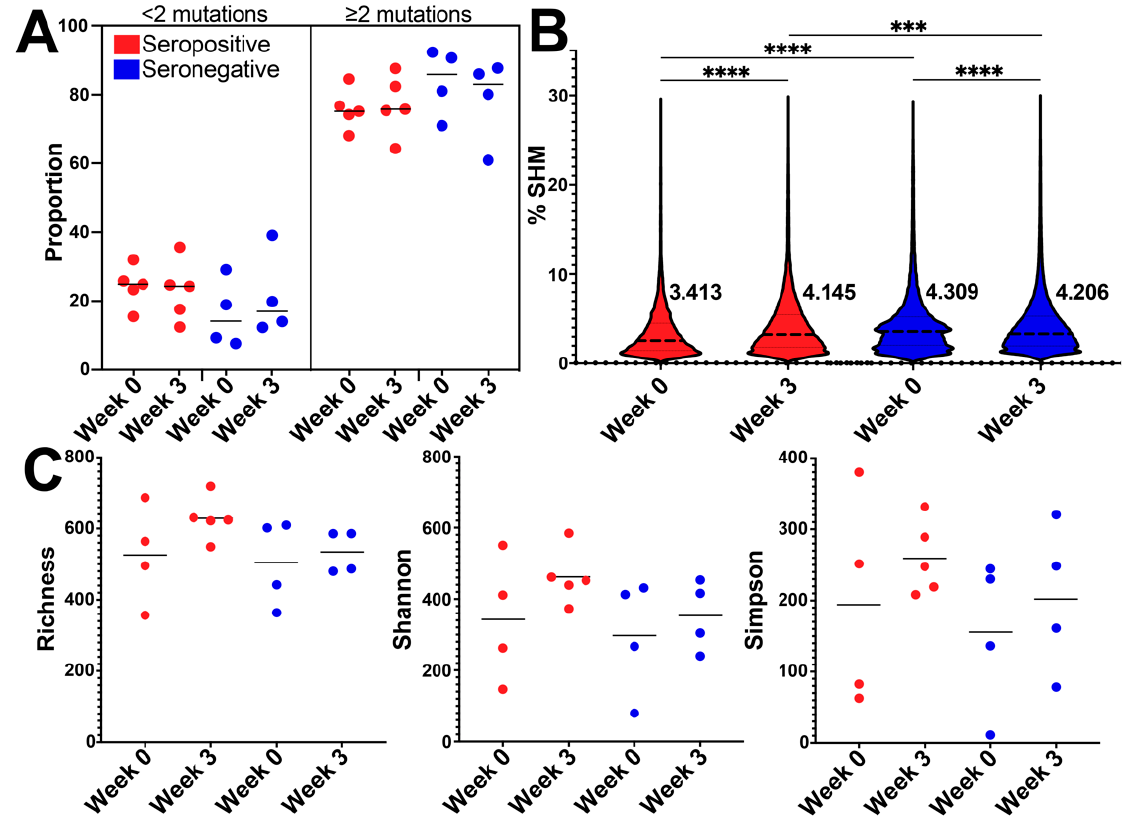
Figure 3. Somatic hypermutation and diversity measures of B cell receptor (BCR) repertoire across serotypes during vaccination. ( A ) Plot depicting the proportion (0–100%) of IgG clones with less than 2 mutations (left) and greater than 2 mutations (right). There were no statistically significant differences in the proportions of seropositive (red) and seronegative (blue) at week 0 or week 3. ( B ) Violin plots depicting percent of SHM for IgG clonotypes in seropositive (red) and seronegative (blue) at weeks 0 and 3. Mean values for each violin are indicated on the plot and by strong dashed lines, quartiles are indicated by thin dashed lines. Statistical test performed was Welch’s t -test, p value **** p < 0.0001, *** p = 0.0002. ( C ) Diversity measures plots including species richness, Shannon diversity, and Simpson diversity indexes. Seropositive is indicated by red, and seronegative by blue and time points: week 0 and week 3.